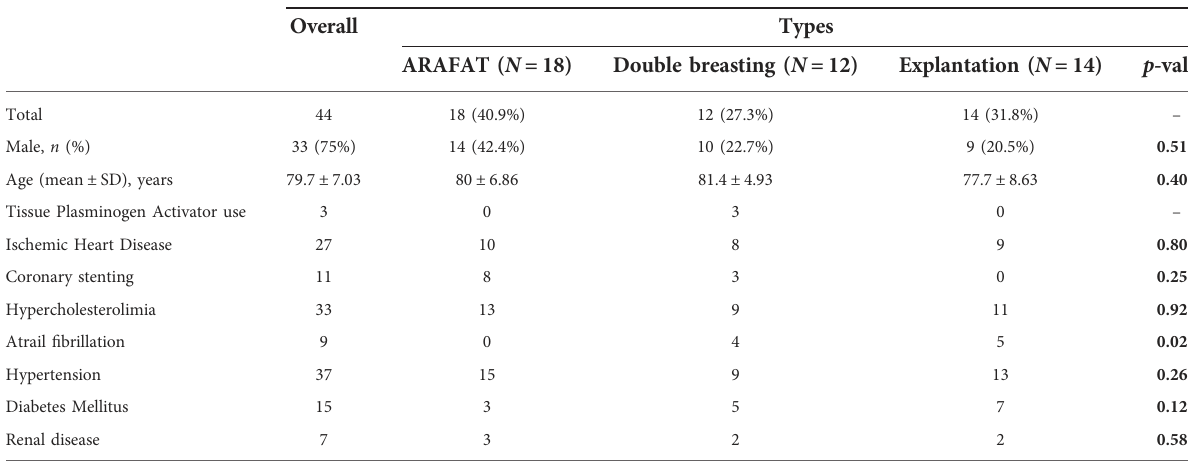
TABLE 1 Baseline characteristics of the patients.